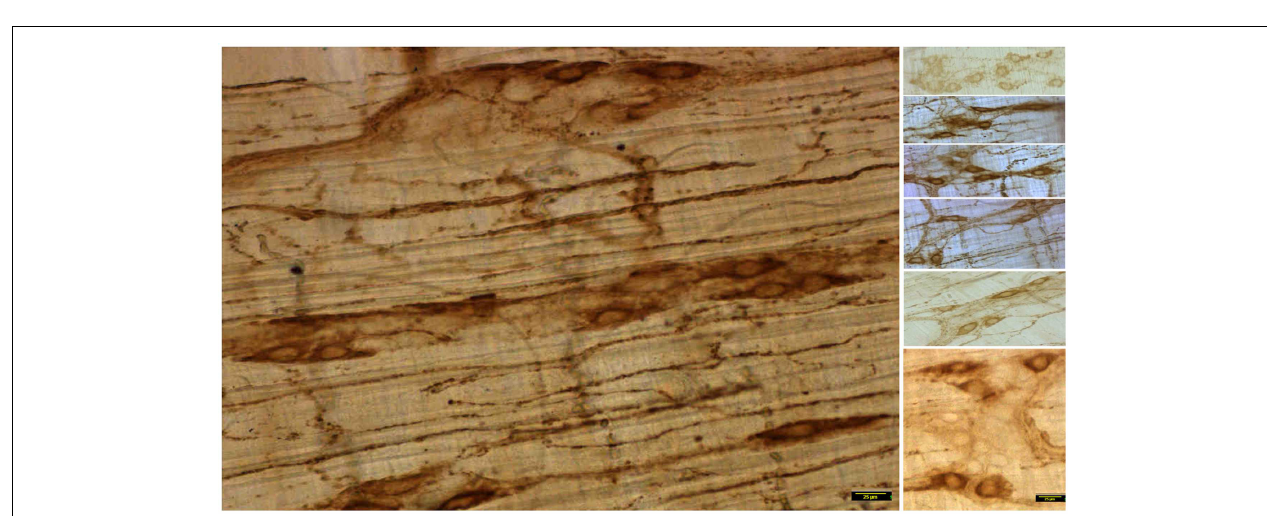
However, the neuronal processes emanating from these cell bodies show nNOS α expression. Note that the lowest panel shows some degenerating neuronal cell bodies. Scale bar representative of each side, 25 µ m.